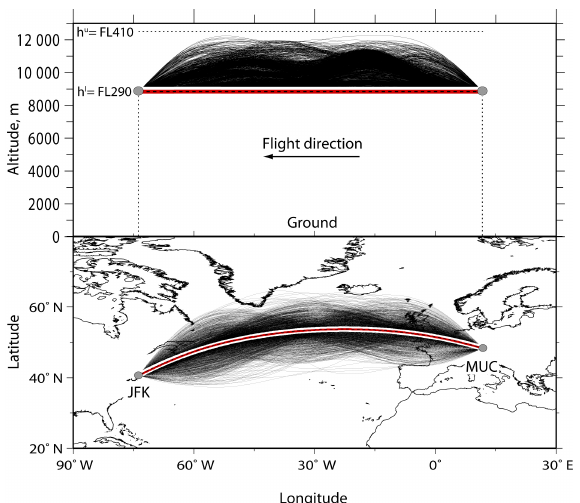
Figure 8. Ten-thousand explored trajectories (solid line, black) from MUC to JFK in the vertical cross section (top) and projection on the Earth (bottom). The population size n p is 100 and the number of generations n g is 100. The best solution (red line) overlaps with the true-optimal solution (dashed line, black), i.e., the great circle at FL290. The flight time of the best solution is 25996.6s, while that of the true-optimal solution is 25994.0s.